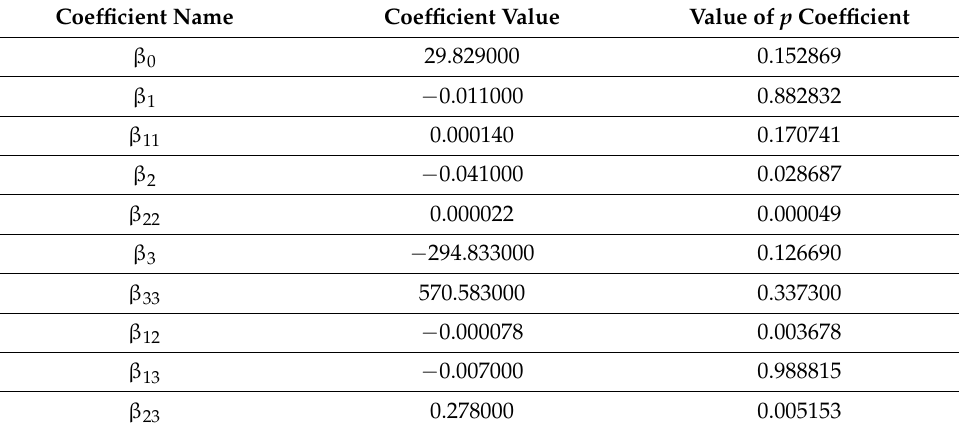
Table 5. Regression and p coefficient